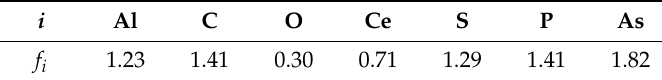
Table 3. Activity coefficients in C104Cr steel at 1873 K.